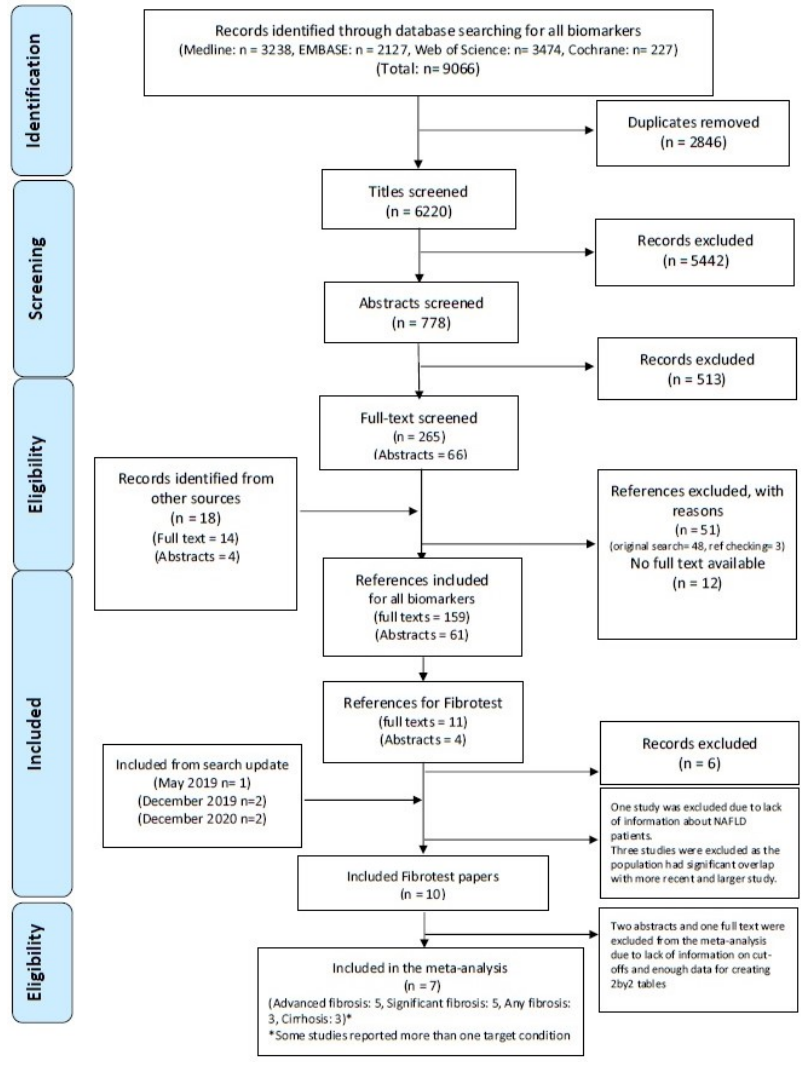
Figure 1. PRISMA flow diagram of primary